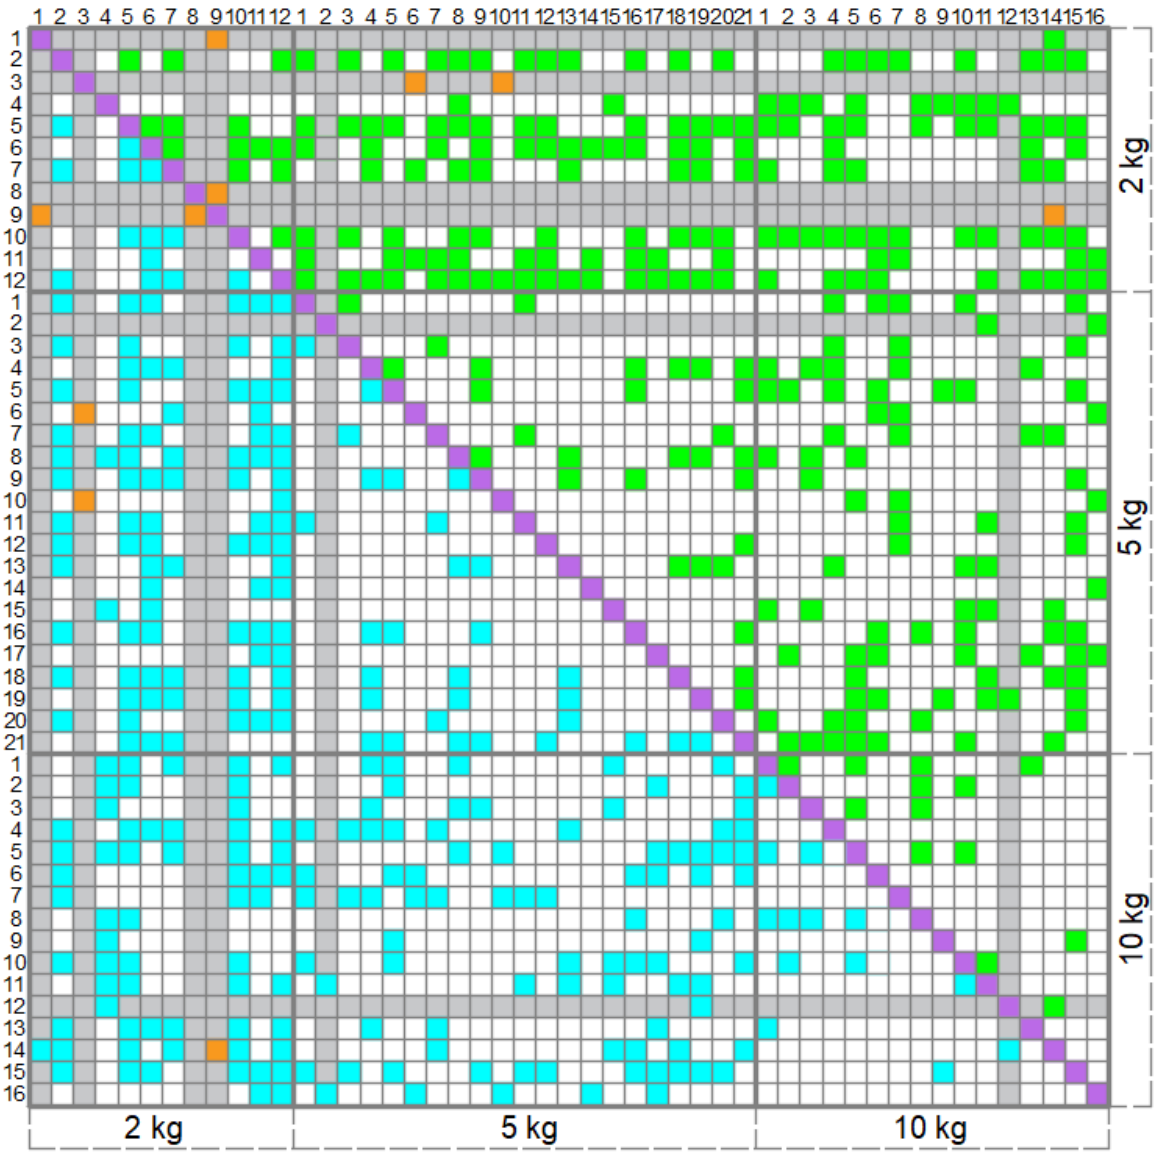
Figure 8. The chart of calibration patches processing, calibration of Sensor2 from 18 April 2022. The explanation on colors is given in the text.